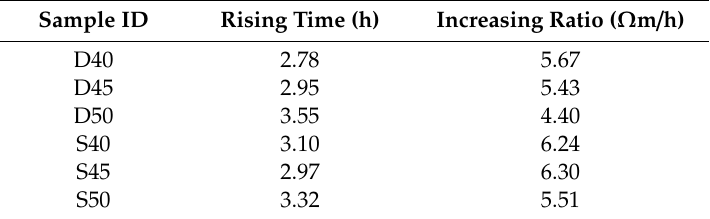
Table 4. Rising time and increasing ratio of electrical resistivity in alkali-activated ground-granulated blast-furnace slag